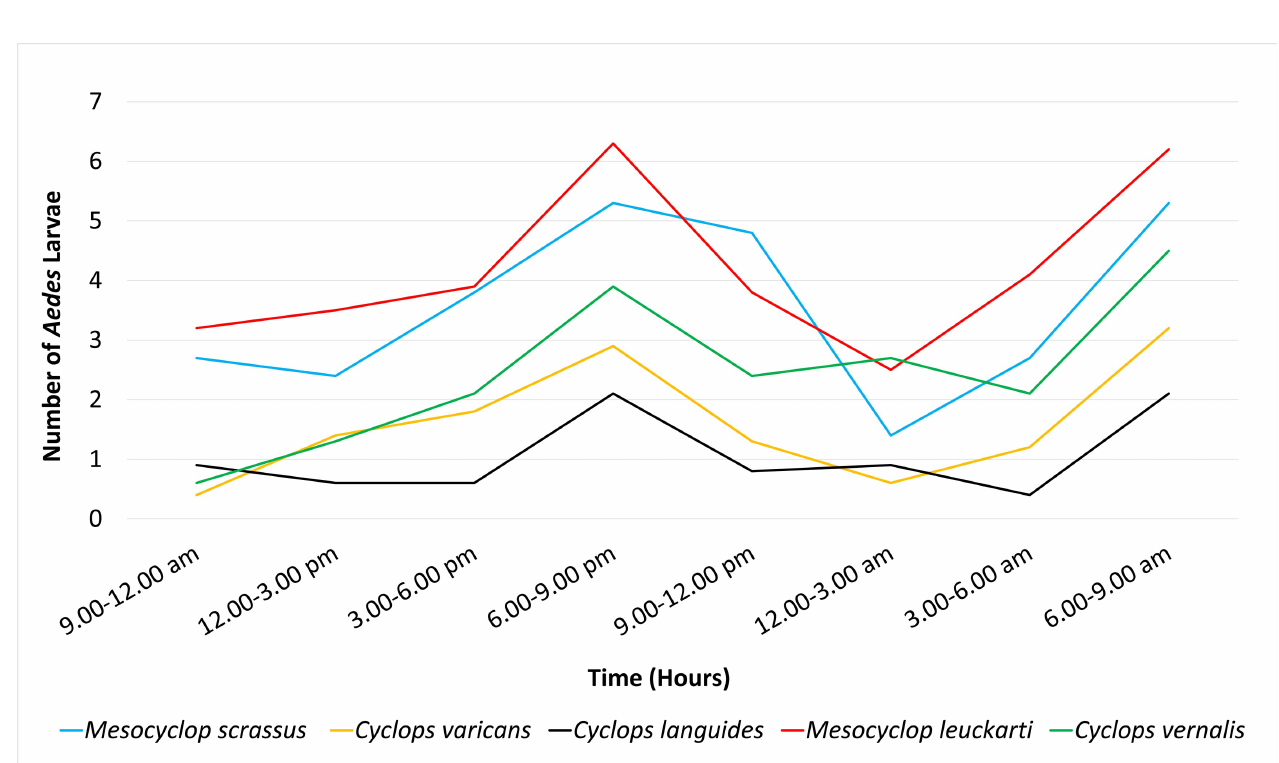
Fig 3. Temporal variation of the predation rates of studied copepods on Ae . albopictus larvae.